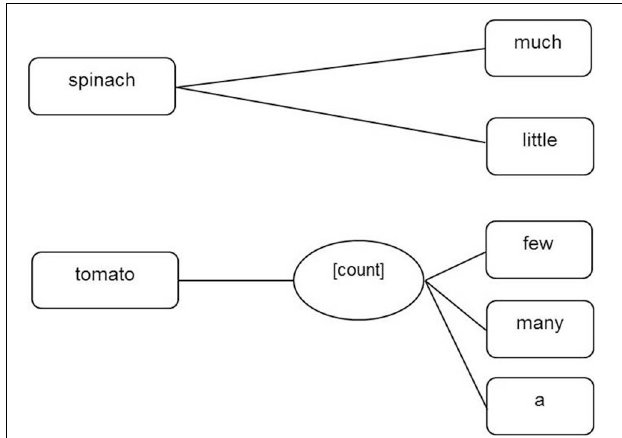
FIGURE 8 | Representation of mass nouns (e.g., spinach) and count nouns (e.g., tomato) at the lemma level derived from Barner and Snedeker’s assumption (2005, 2006).